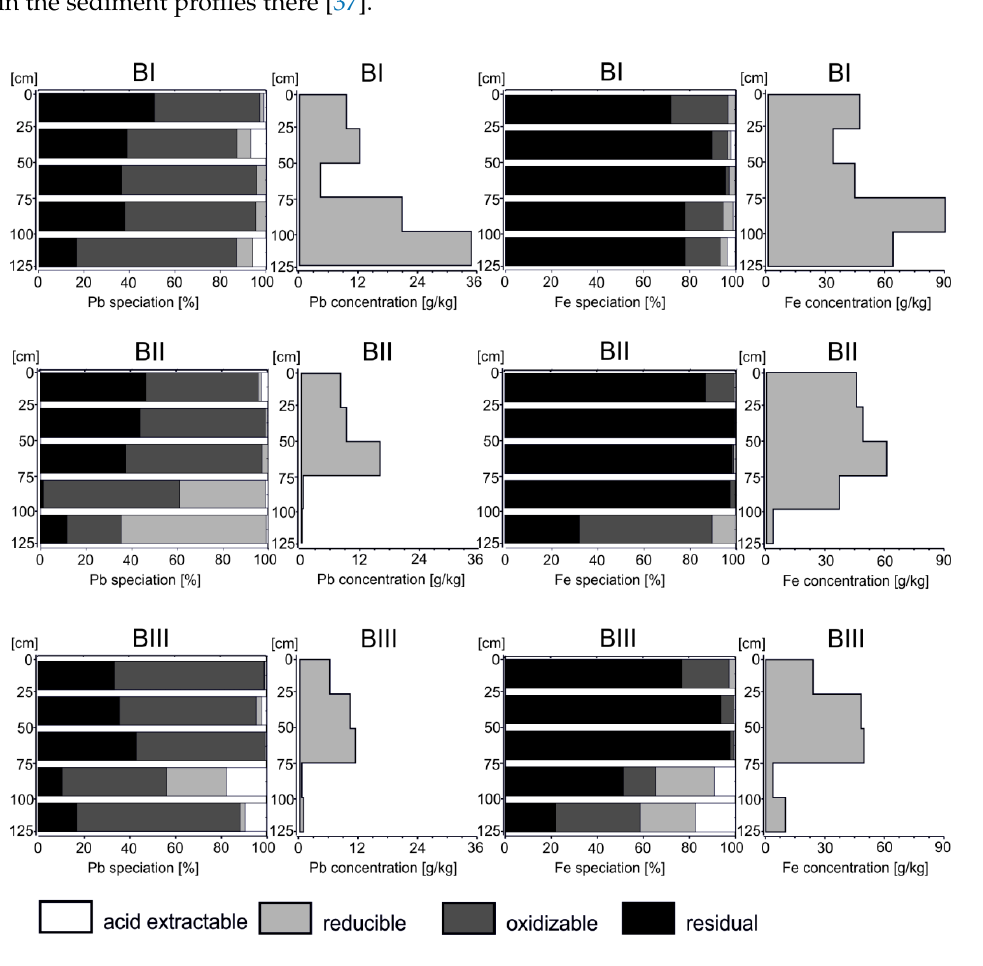
Figure 5. Pb and Fe content and speciation in the Bia ł a River sediments.